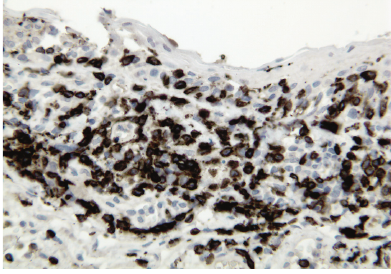
Figure 1: Bone marrow trephine core biopsy shows a single paratrabecular lymphoid aggregate, characteristic of bone marrow involvement by follicular lymphoma (hematoxylin and eosin stain, 20x).